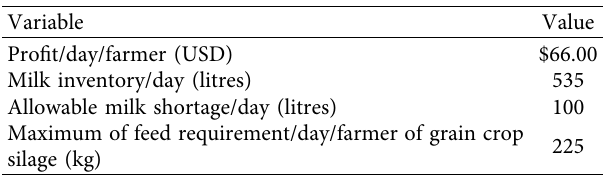
Table 5: Summary of results.